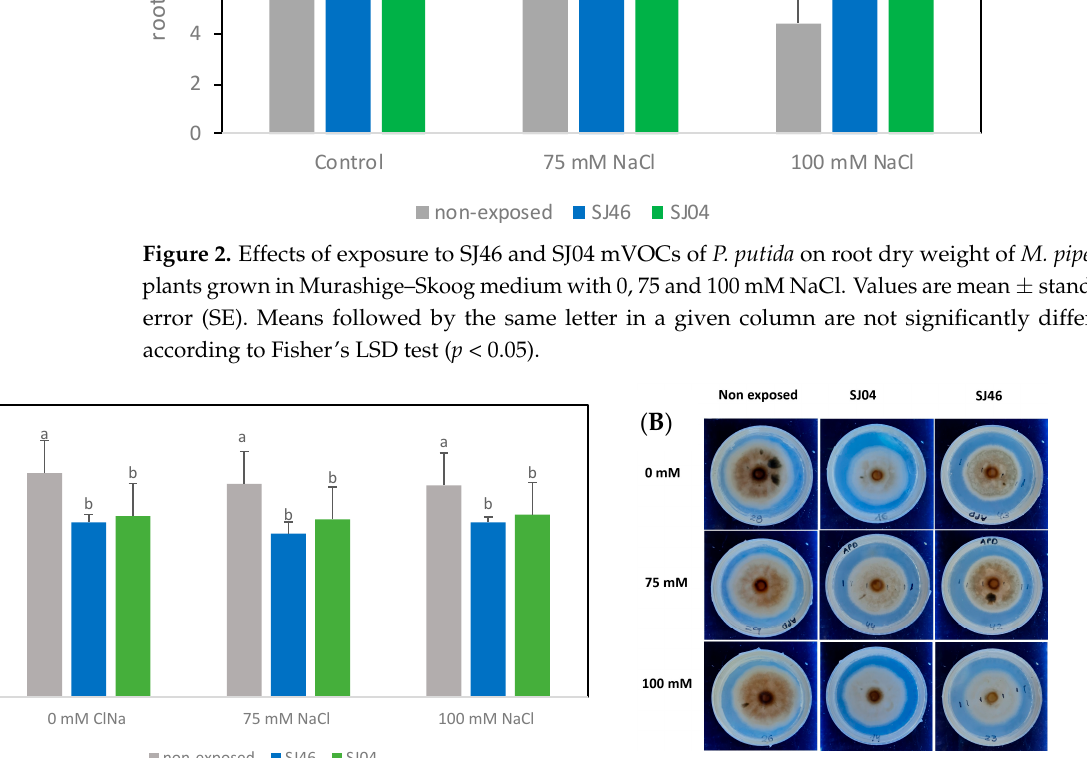
Figure 3. ( A ) Effect of the mVOCs of two PGPR, P. putida SJ04 and SJ46, grown under salt stress conditions (0 mM, 75 mM and 100 mM) on the growth of A. alternata on the sixth day of the challenge. ( B ) Photos of A. alternata cultures exposed to different treatments. Different letters indicate statistically significant differences. Fisher’s LSD test ( p < 0.05). It was observed that the mycelial growth of A. alternata when grown under non-ex- posed conditions to the mVOCs at di ff erent salt concentrations (0, 75 and 100 mM) at 2, 4 and 6 days did not cause any signi fi cant di ff erences ( p > 0.05) (Figure 4A), with the same tendency being observed when exposed to SJ46 or SJ04 mVOC emissions grown under di ff erent salt levels (Figure 4B,C). Figure 4. E ff ect of mVOCs of ( A ) control (non-exposed), ( B ) P. putida SJ46 and ( C ) SJ04 on A. alternata growing under different salt levels.